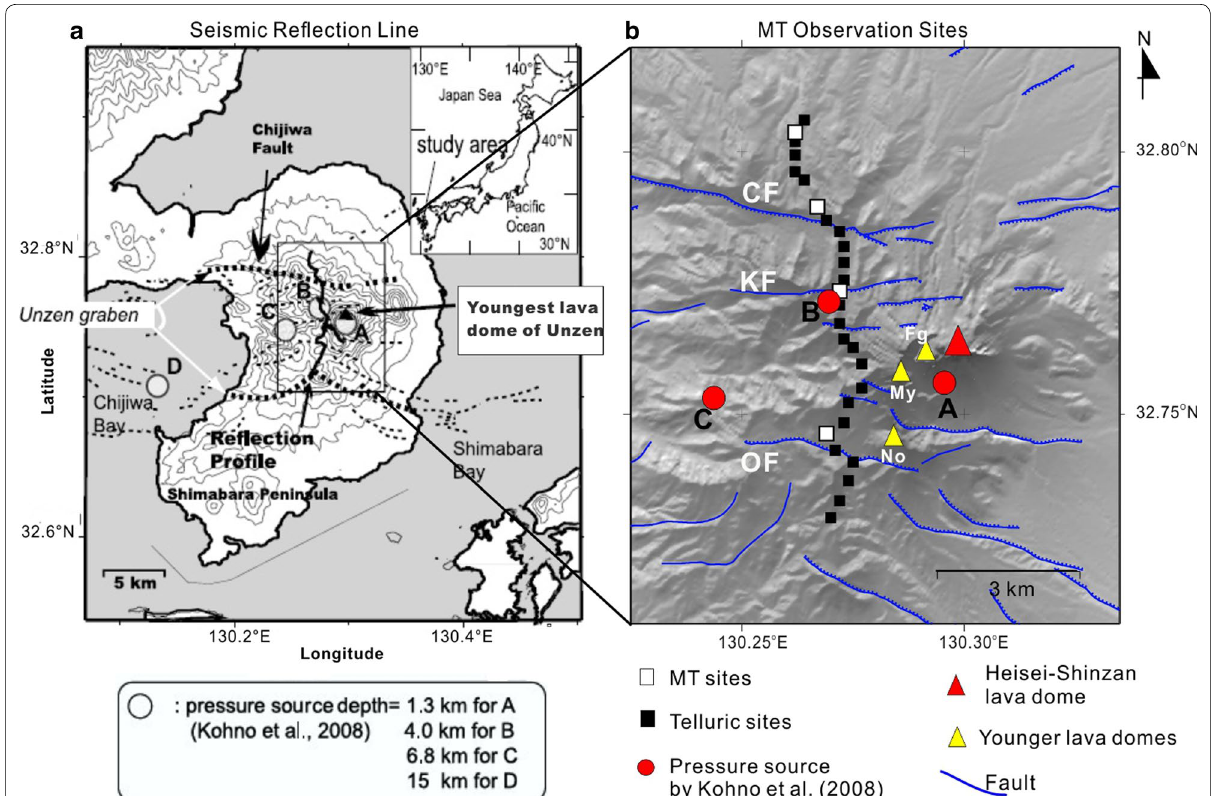
Fig. 1 a Map showing the location of the seismic reflection survey (solid black line) undertaken by Matsumoto et al. (2012). Thin black dashed lines represent faults in the graben, and gray circles indicate pressure sources inferred from leveling and GPS data (Kohno et al. 2008). Figure courtesy of Matsumoto et al. (2012). b Broadband magnetotelluric (MT) observation sites. Map area is indicated by the rectangle in a . Faults (after Tsutsumi 2015) are represented by blue lines with teeth. CF is the Chijiwa Fault, KF is the Kusenbu Fault, and OF is the Oshidorino-Ike Fault. Other lines are minor or unnamed faults. Pressure sources are as in a . Younger lava domes ( No Nodake, My Myokendake, Fg Fugendake; Hoshizumi et al. 1999) are indicated by yellow